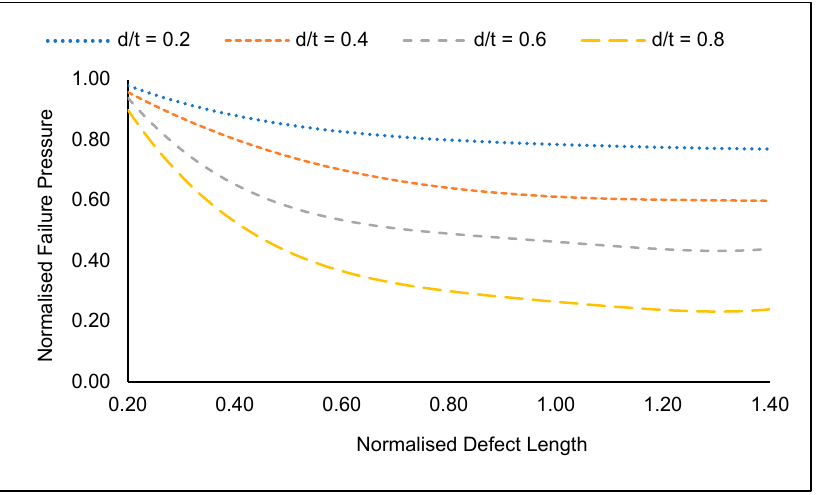
Figure 10. Normalised failure pressures of corroded API 5L X80 pipe elbow subjected to a normalised axial compressive stress of 0.2 for a single defect located at the intrados.